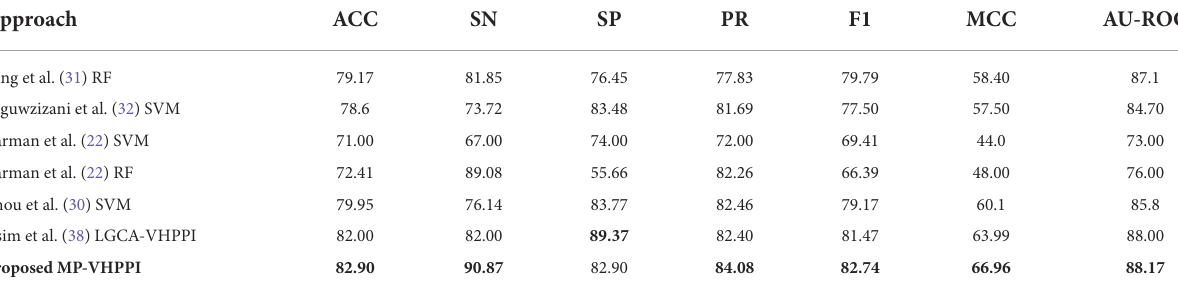
TABLE 3 Performance comparison of proposed MP-VHPPI with existing viral-host PPI predictors over a benchmark Barman dataset in terms of 7 different evaluation measures. Approach ACC SN SP